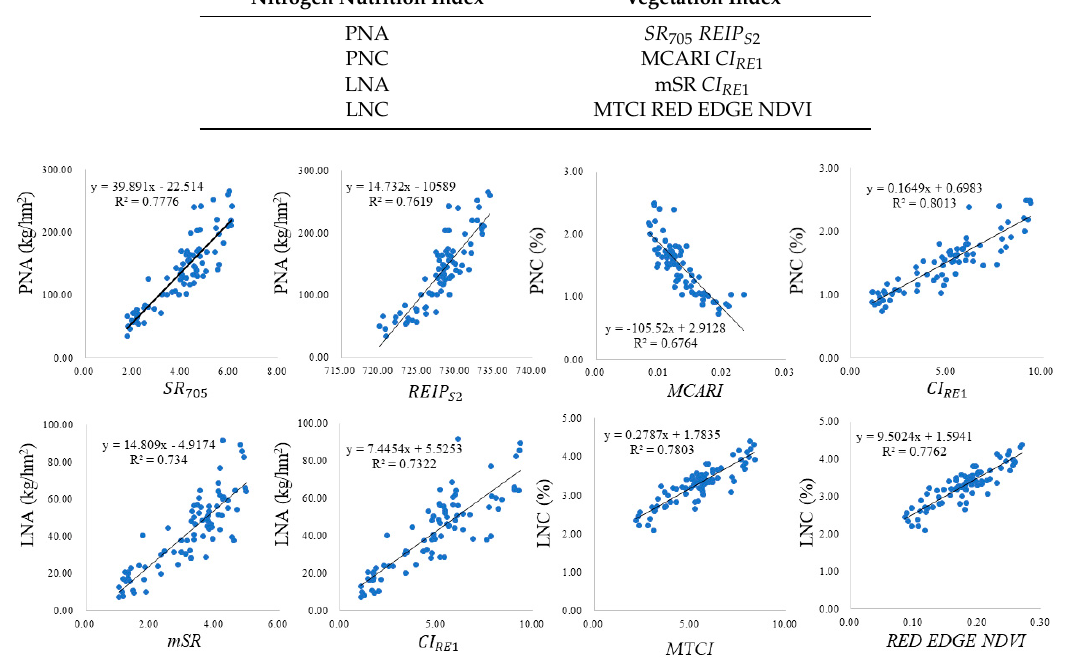
Table 6. Vegetation indices selected for inversion of each nitrogen parameters.